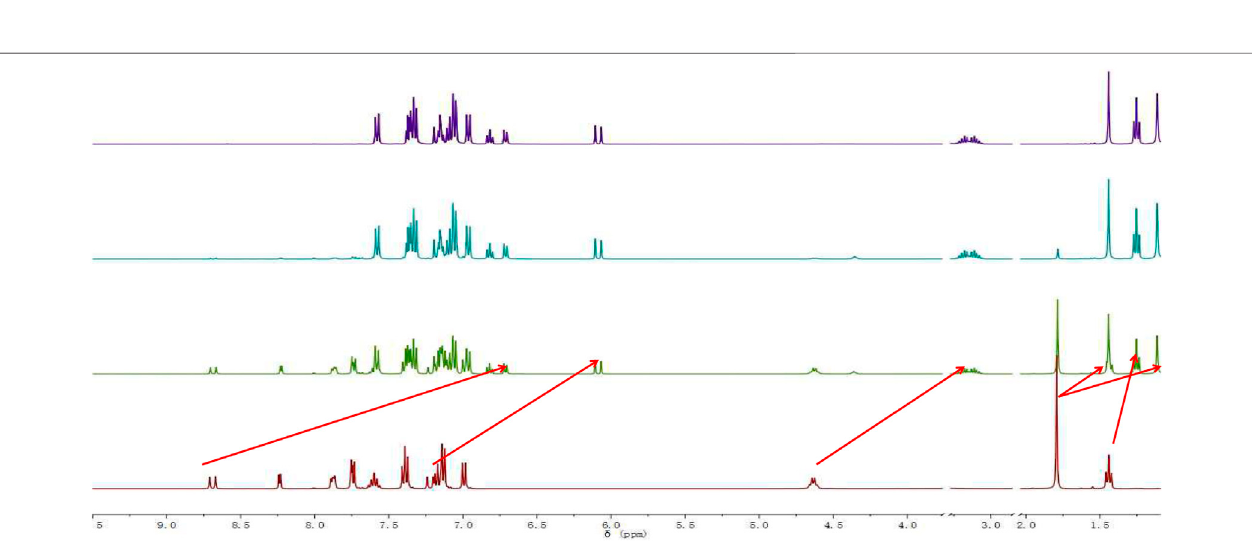
FIGURE 12 | High-resolution mass spectra (HRMS) of the reaction product of probe W upon the addition of CN − .